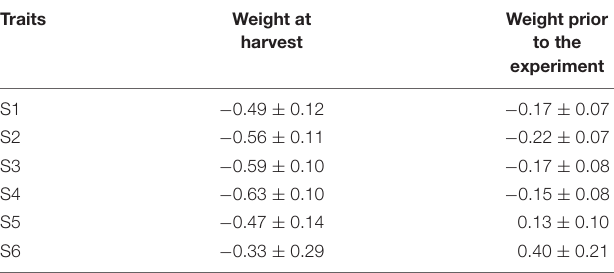
Weight prior to